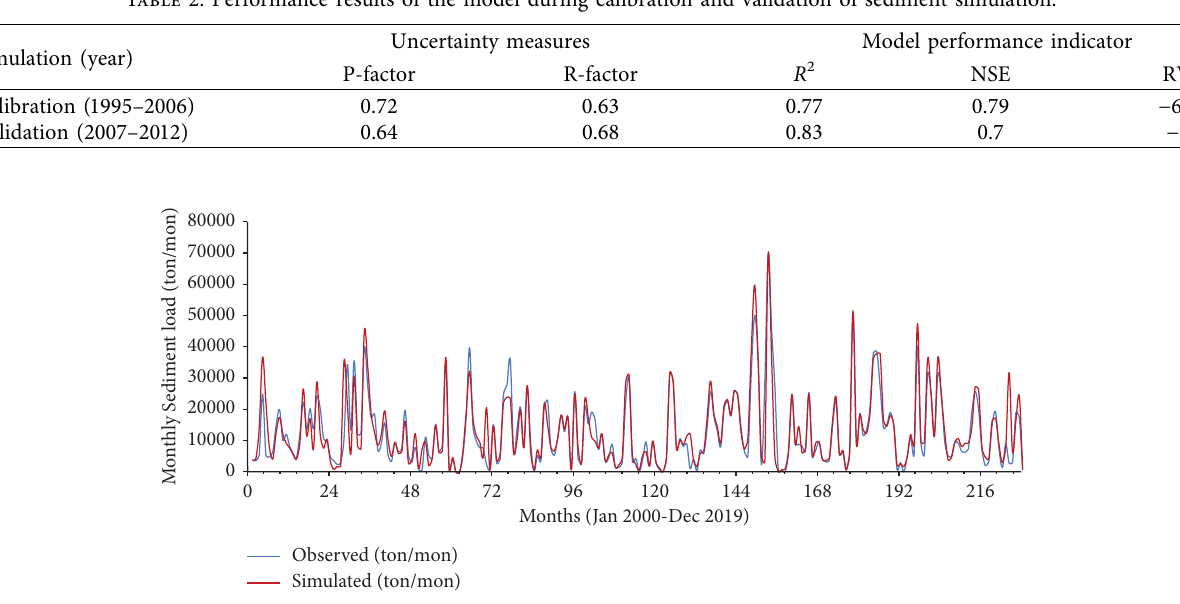
Figure 2: Calibration and validation of monthly sediment load. Table 3: Average yearly yield of sediment for hotspot subbasins of Kulfo